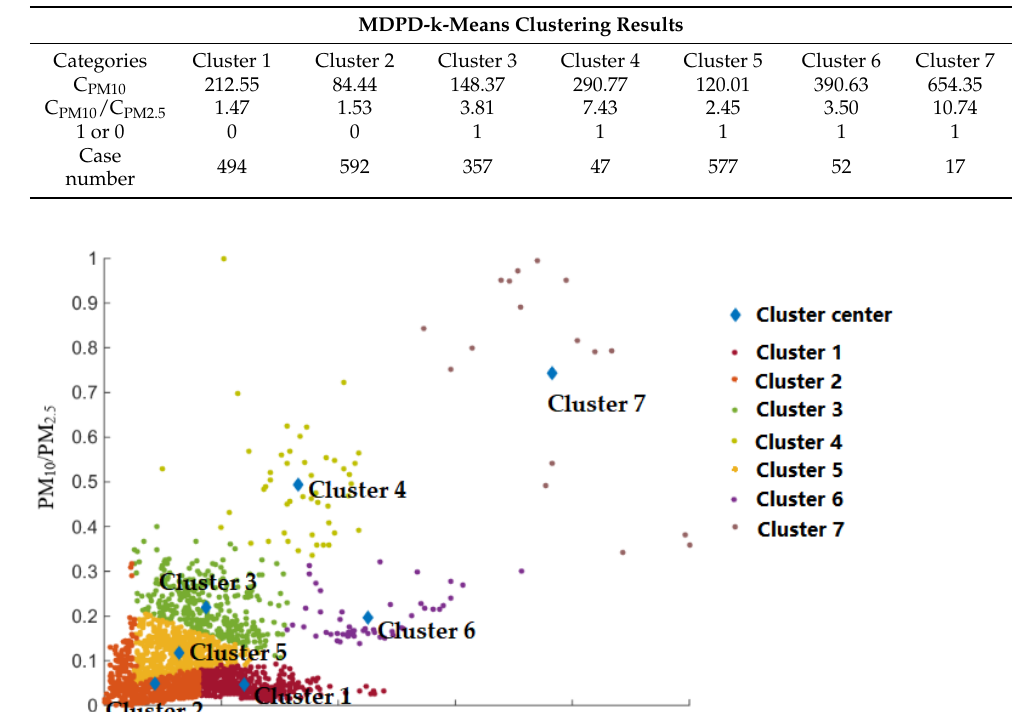
Table 3. The clustering results and dust data judgment of MDPD-k-means algorithm.